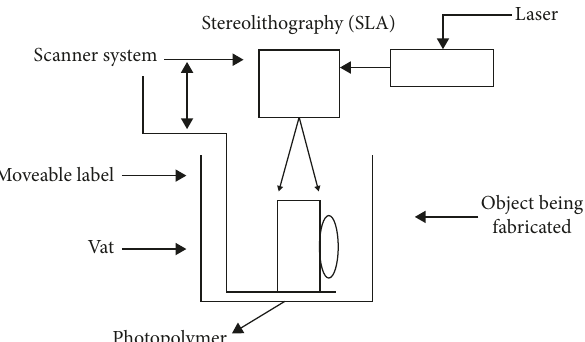
Figure 3: Stereolithography